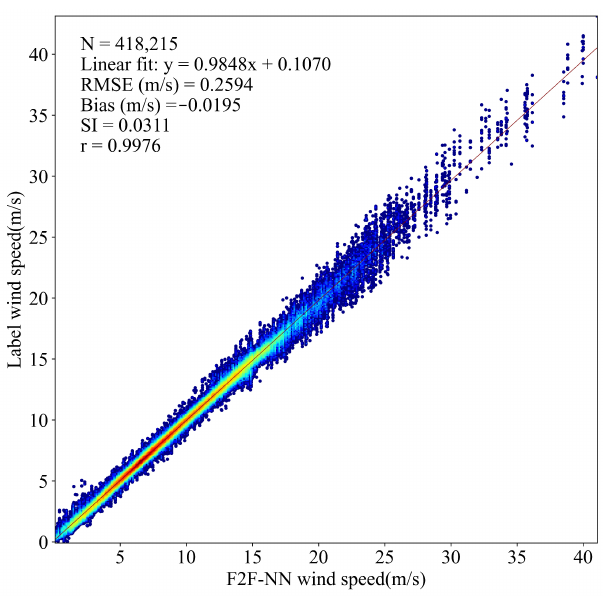
Figure 5. Comparison between F2F-NN wind speed and label wind